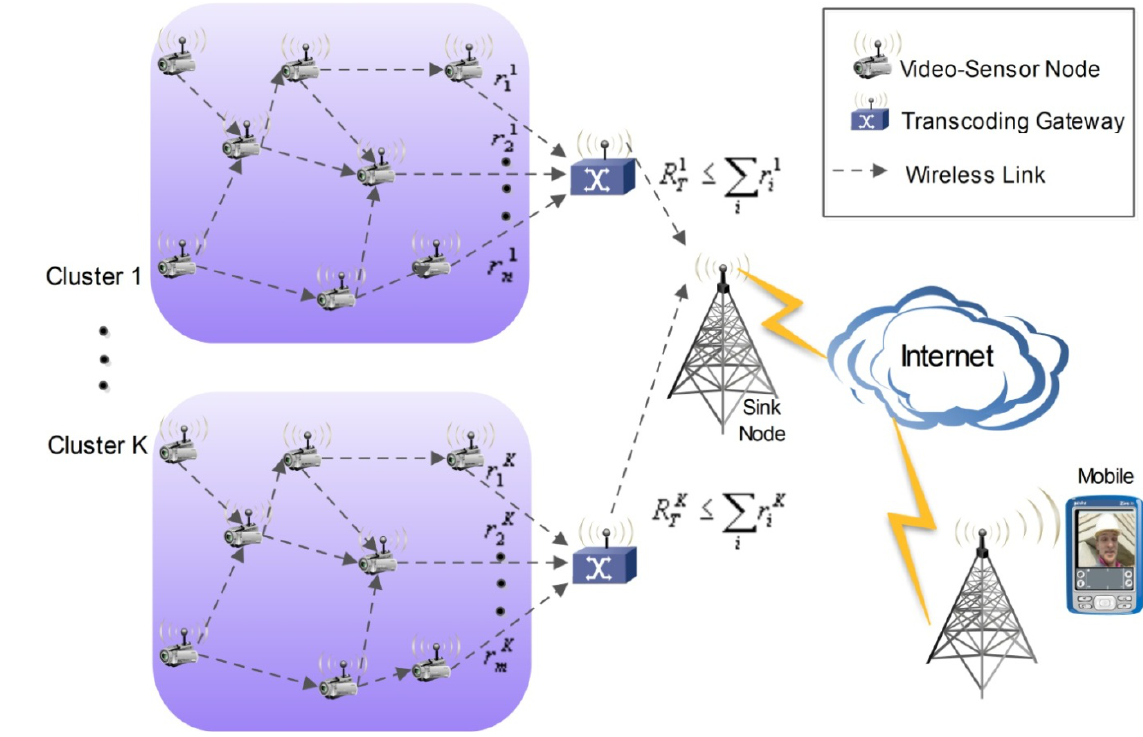
Figure 4. Proposed VSN